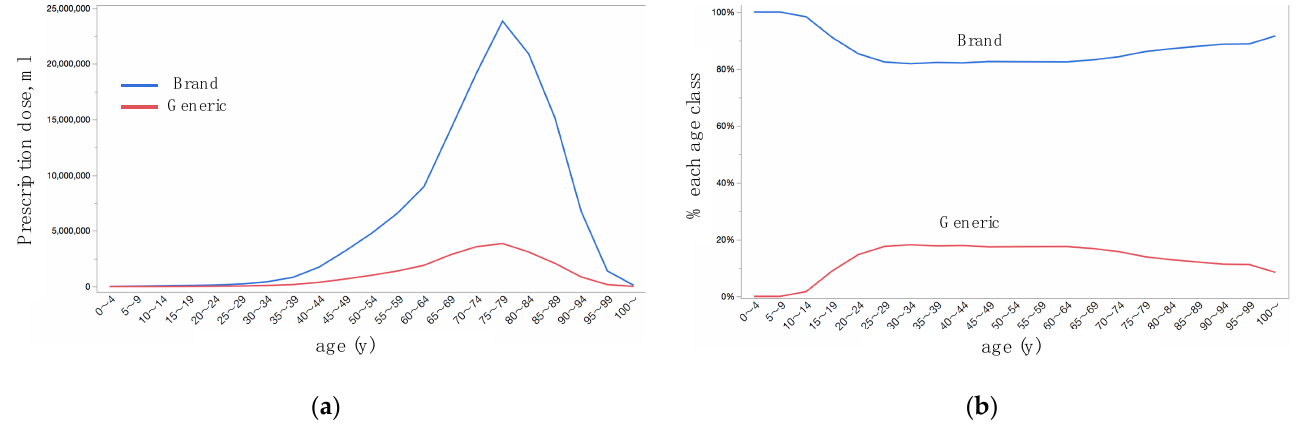
Figure 3. Age-dependent distributions of prescription dose of topical anti-glaucoma medications stratified by single medication formulation or fixed-dose combination. ( a ) Actual prescription dose. ( b ) Percentage of prescription dose in each age class. FDC, fixed-dose combination.